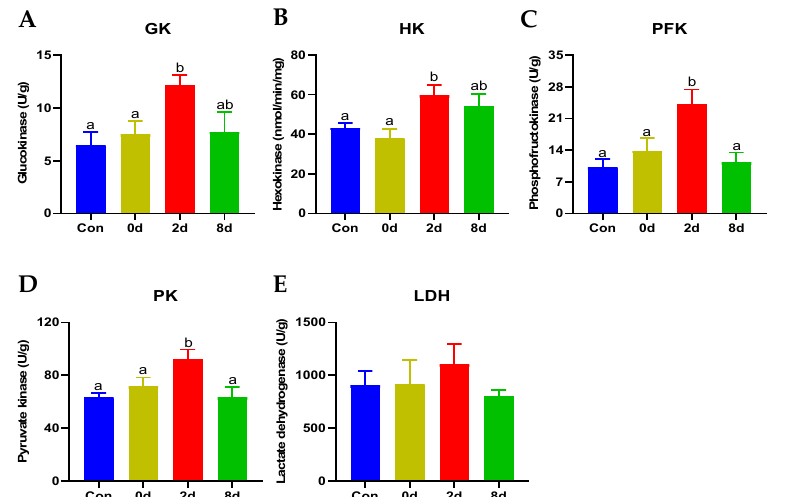
Figure 3. Effects of chronic hypothermia on glucometabolism of freshwater drum. ( A ) Glucokinase, GK; ( B ) Hexokinase, HK; ( C ) Phosphofructokinase, PFK; ( D ) Pyruvate kinase, PK; ( E ) Lactate dehy- drogenase, LDH. Data were calculated by one-way ANOVA analysis with SPSS 23.0. The significant differences are considered to exist when p < 0.05, and marked with different letters. Results were expressed as mean ± SEM, n =